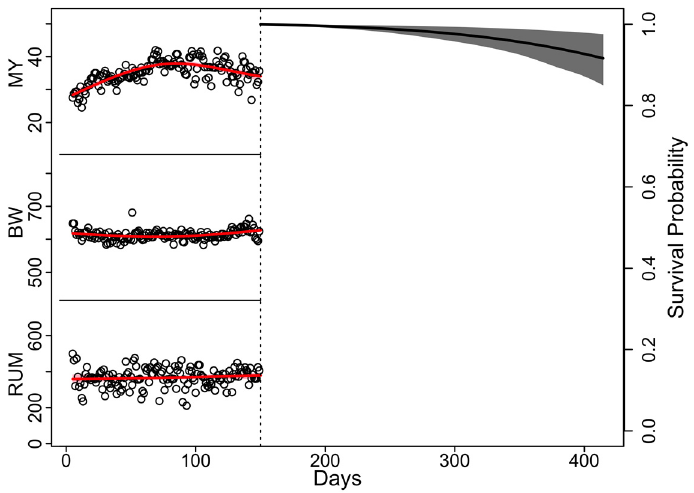
Figure 2. Predicted survival function from 150 DIM of the first lactation (dotted line) to the second calving (414 days post-first calving) for one cow of one farm, randomly chosen. The multivariate joint model estimates the evolutions of the sensor data (MY = Milk yield (kg), BW = Body weight (kg), RUM = Rumination time (min)) until 150 DIM of the first lactation (red curves) and, based on those, predicts the survival function until the second calving (black